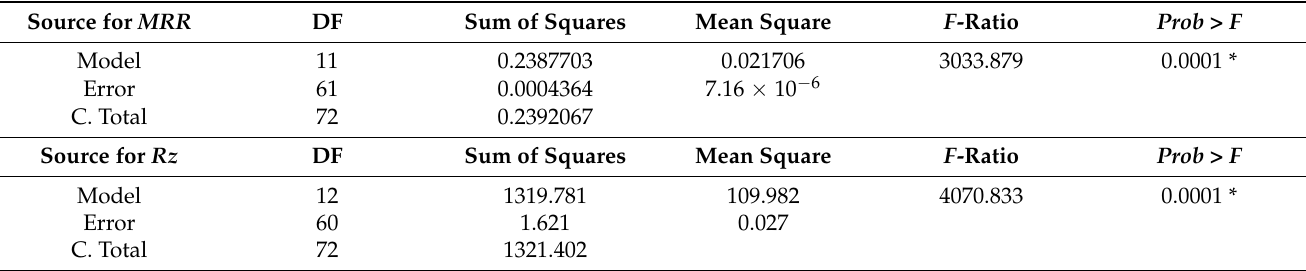
Table 7. Results of evaluation of MSC models for prediction of MRR and Rz parameters by ANOVA.